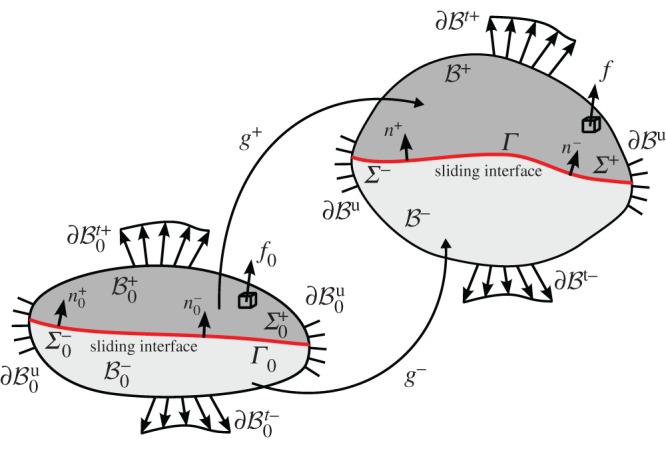
Deformation of a solid containing a sliding interface. B0 and B denote the reference and current configuration, respectively. (Online version in colour.)